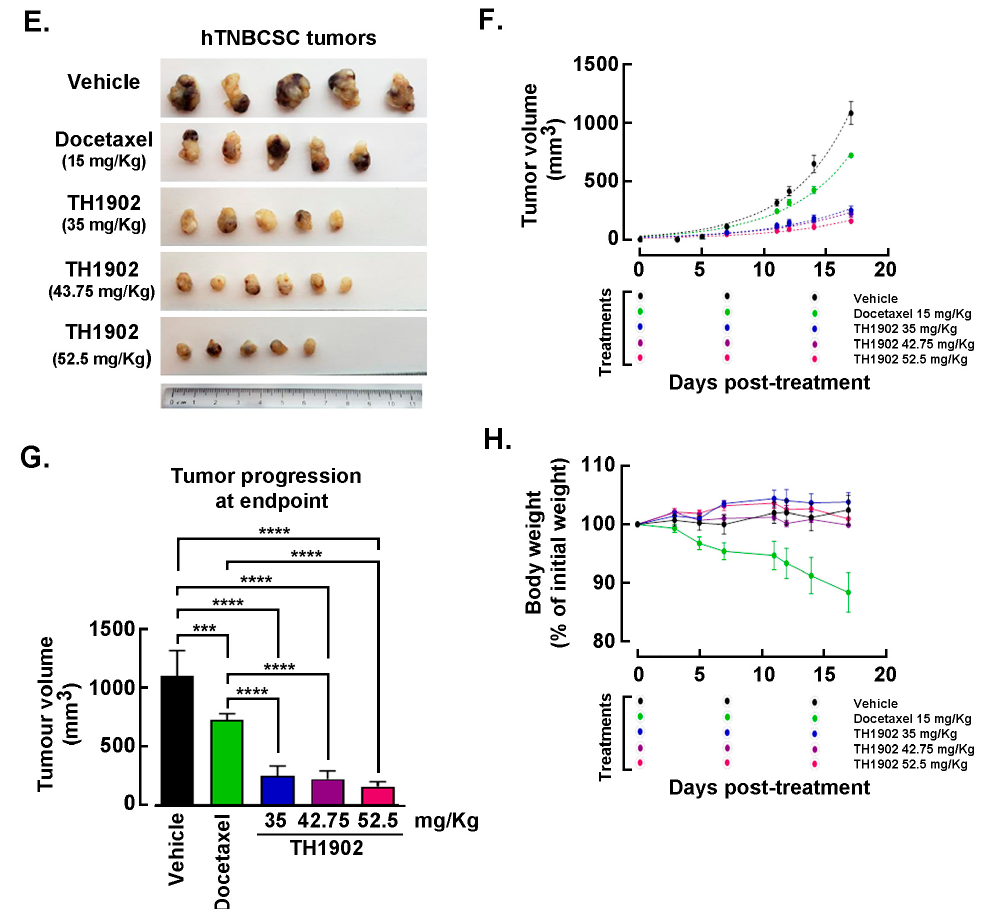
Figure 6. Growth of hTNBCSC and hOvCSC xenografts within mice following administration of docetaxel or TH1902. At 3 days following subcutaneous implantation of hTNBCSC or hOvCSC xenografts within immunodeficient mice, animals began receiving weekly administration of vehicle, docetaxel (3.75 or 15 mg/kg) or TH1902 (8.75, 35, 42.75 or 52.5 mg/kg, first two containing docetaxel levels equivalent to those in the two docetaxel dosages). The tumor pictures were taken for ( A ) hTNBCSC and ( E ) hOvCSC, and size ( B , F ) was measured manually at regular intervals in order to monitor the effects of test article administration on tumor growth. Symbols represent means ± SEM, n = 5 to 6. Note that there is virtual overlap between the 15 mg/kg docetaxel curve and the 8.75 mg/kg TH1902 curve. The symbols displayed below the abscissa denote the days on which treatments occurred. Note also that docetaxel (15 mg/kg) was only administered three times as that combined quantity matches the maximum tolerated dose (MTD) for docetaxel in mice. Statistical comparison between the different treatments of ( C ) hTNBCSC or ( G ) hOvCSC was performed by calculating the change in tumor sizes between the first day of treatment and the last day of the experiment. The sizes were compared by one-way ANOVA and the mean values for tumor sizes associated with each treatment were compared to the tumor sizes for vehicle-treated animals using Dunnett’s multiple comparison test with p < 0.05 as the pre-set level of significance (ns = non significant, * p < 0.05, *** p < 0.001, **** p < 0.0001). During the treatments, body weights of the mice were routinely recorded and considered as a rough estimate of morbidity. The data is shown here as a percentage of the animal’s body weight at the beginning of treatment ( D , H ). Symbols represent means ± SEM, n = 5 to 6. The symbols displayed below the abscissa indicate the days on which treatments occurred. The treatments listed along the abscissa identify the treatment along with the concentration used (in mg/kg) listed in brackets.